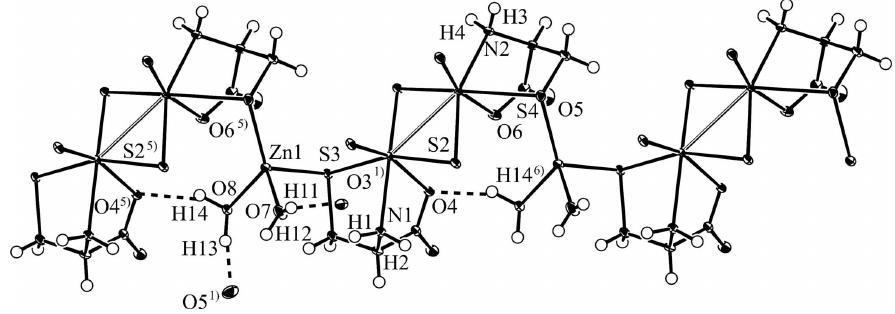
Figure 2 A view of part of a one-dimensional polymeric chain with hydrogen bonds (dashed lines). catena-Poly[[diaquazinc(II)]- µ -L-cysteinato(2-)- κ 4 S:S,N,O-[di- µ -sulfido- bis[oxidomolybdate(V)](Mo—Mo)]- µ -L- cysteinato(2-)- κ 4 S,N,O:S] Crystal